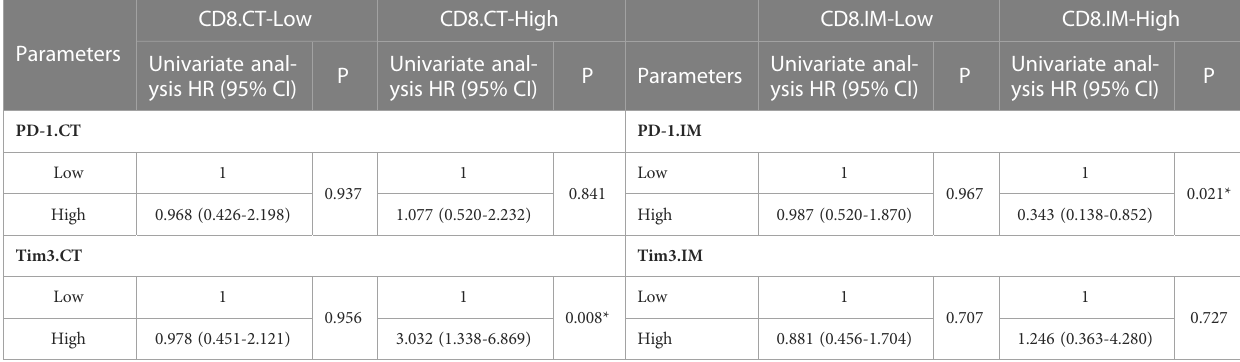
TABLE 8 Cox regression survival analysis according to CD8 high and low subgroups.